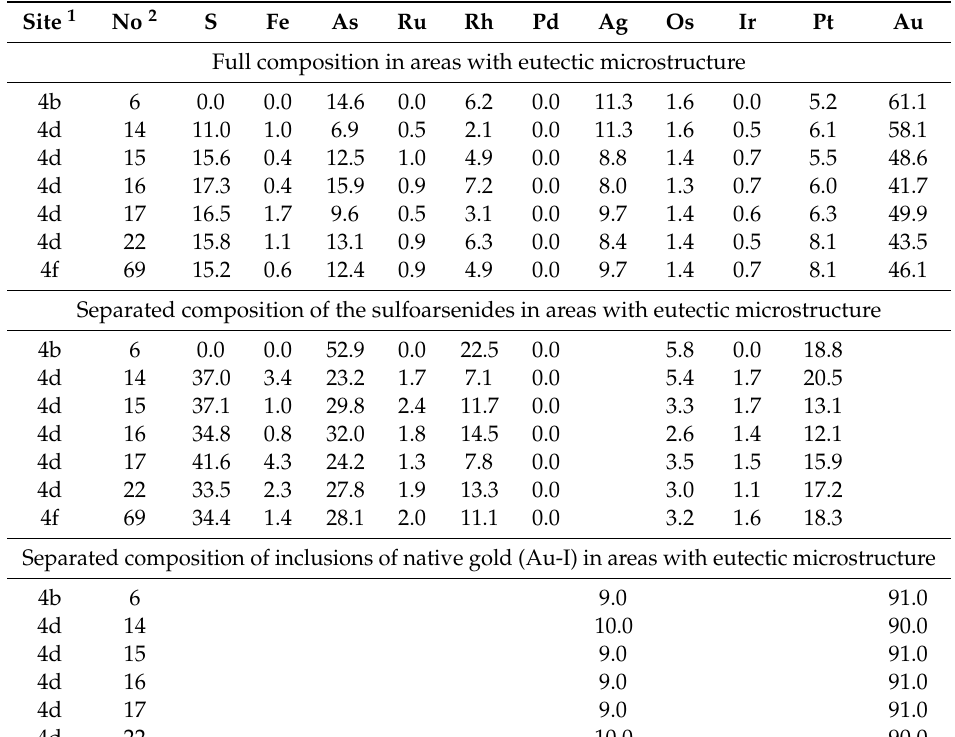
Figure 6. The areas of detail 4d of grain No. 3. Distribution patterns obtained in the mapping mode: Au, Ag, Rh, Ru, As, S, Pt. Table 8. Full and “separated” chemical composition (at.%) (SEM-EDS method) Rim-I in areas with eutectic